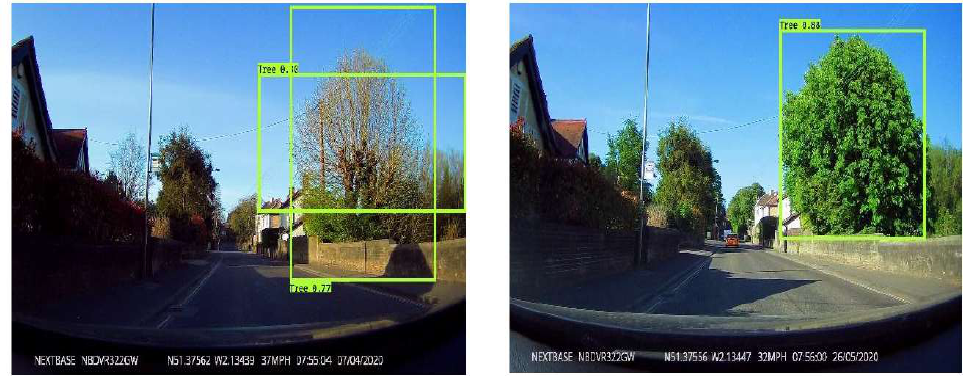
Figure 1. Example comparison of detector outputs between leaf-off and leaf-on trees. The GCC data for HSV ROI images and an example of images used, are plotted for AOI_2, AOI_3, AOI_4, and AOI_5a and b (Figure 2). The phenological signal is clearly well-defined for each AOI—for some AOIs the classic trapezoid phenology profile is displayed; for all AOIs the greenness values are seen to increase rapidly from the start of the time period (March) through to the end of the time period (May). This corresponded to a period of leafing-on in the deciduous trees and associated increased photosynthetic activity. The HSV processing had a stretching effect on the GCC values up until the start of green-up, after which it relatively smoothed the values.